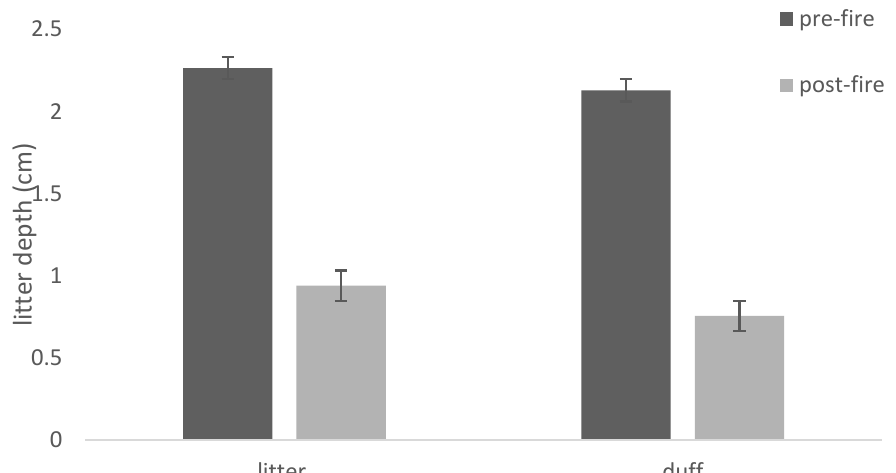
Figure 7. Mean depth of litter and depth layers (+1 S.E.) measured in fuels plots for the pre- and post-fire sampling intervals.